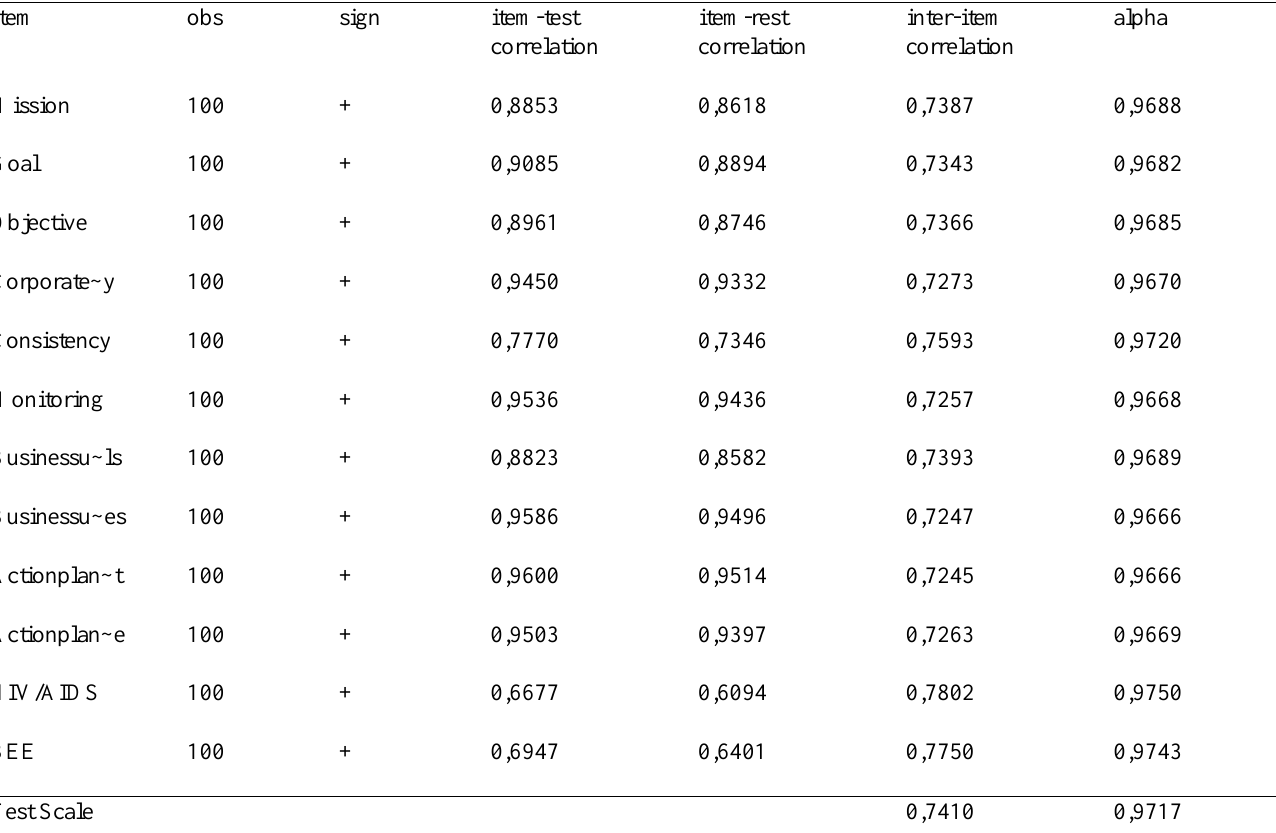
Table 5: Cronbach alpha analysis for internal